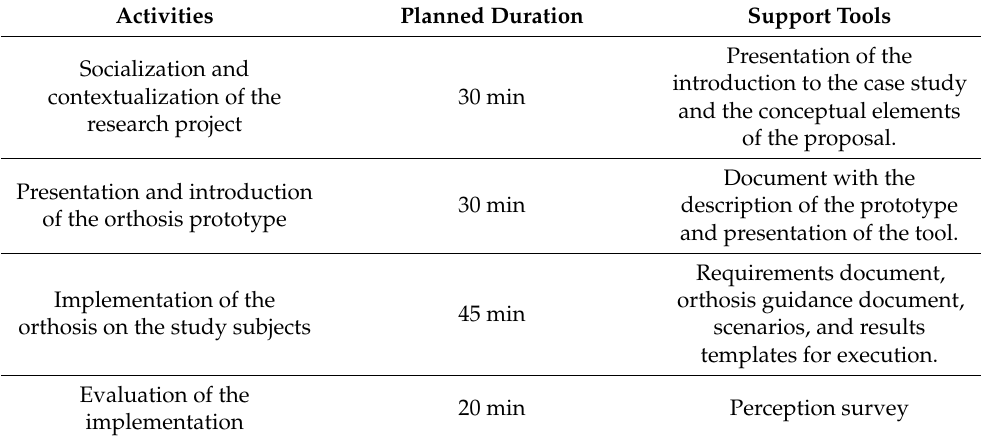
Table 5. List of activities conducted in the case